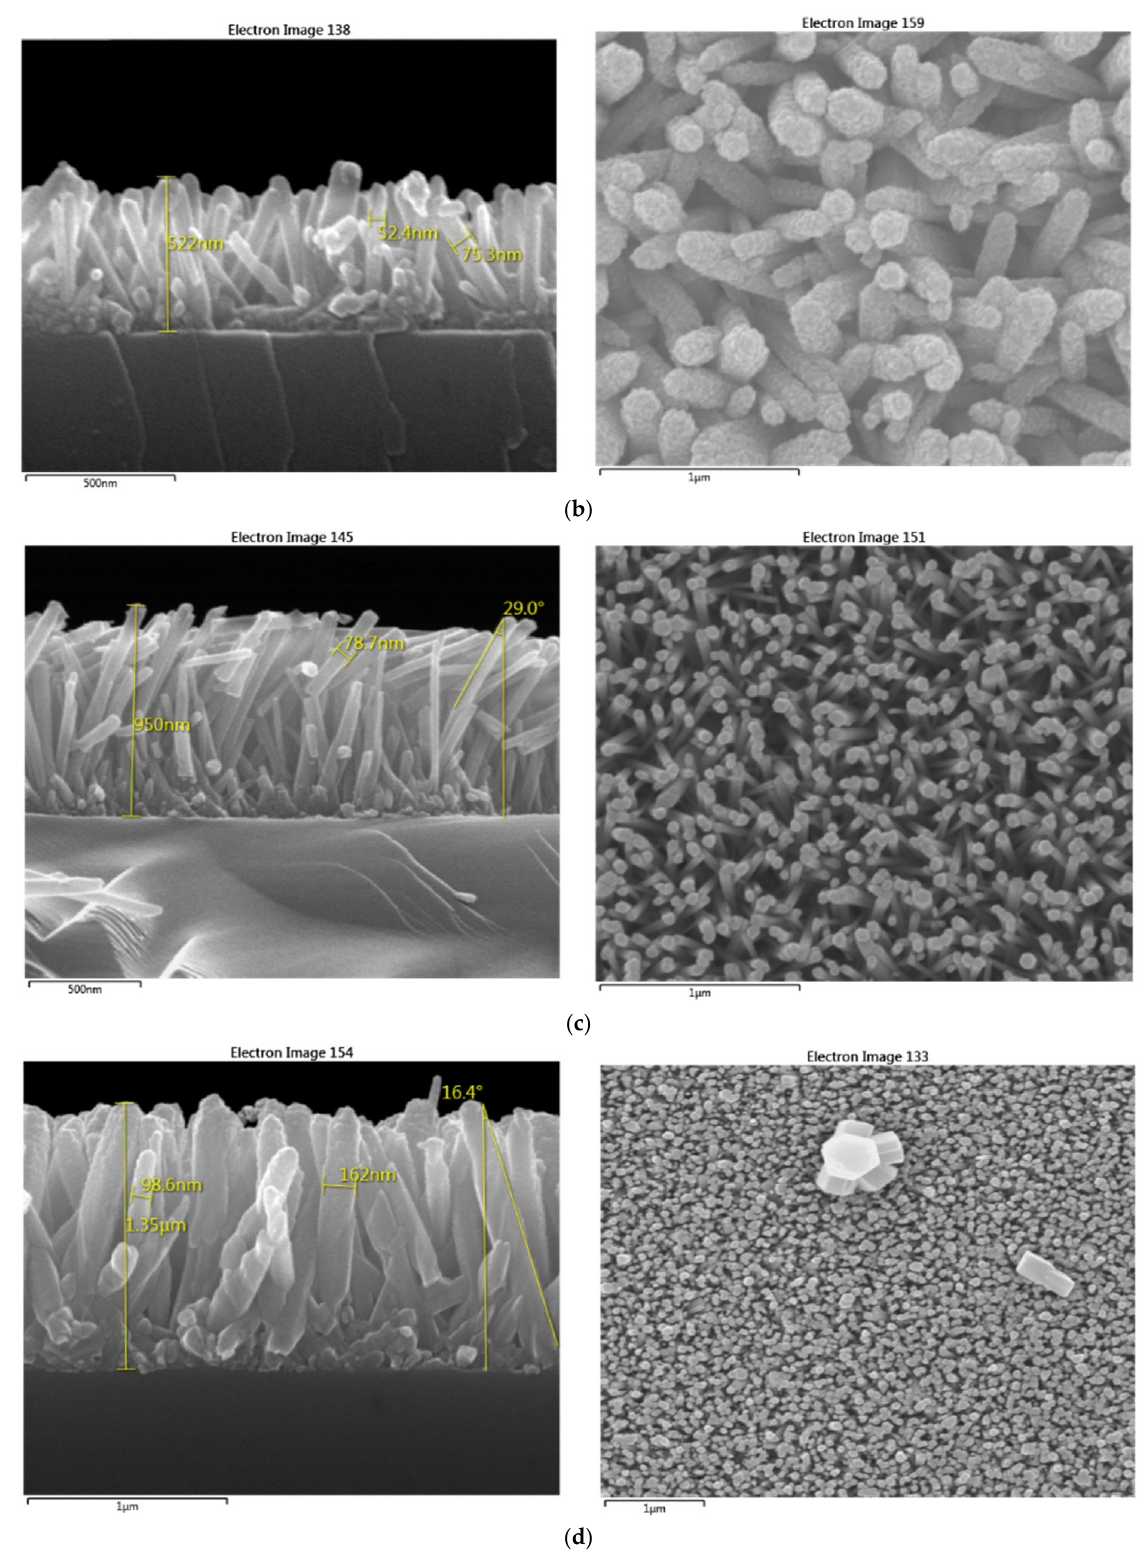
Figure 2. ( a ). SEM images of ZnO thin films prepared by hydrothermal evaporation on silicon substrates at pH 8.0. ( b ). SEM images of ZnO thin films prepared by hydrothermal evaporation on silicon substrates at pH 9.0. ( c ). SEM images of ZnO thin films prepared by hydrothermal evaporation on silicon substrates at pH 9.5. ( d ). SEM images of ZnO thin films prepared by hydrothermal evaporation on silicon substrates at pH